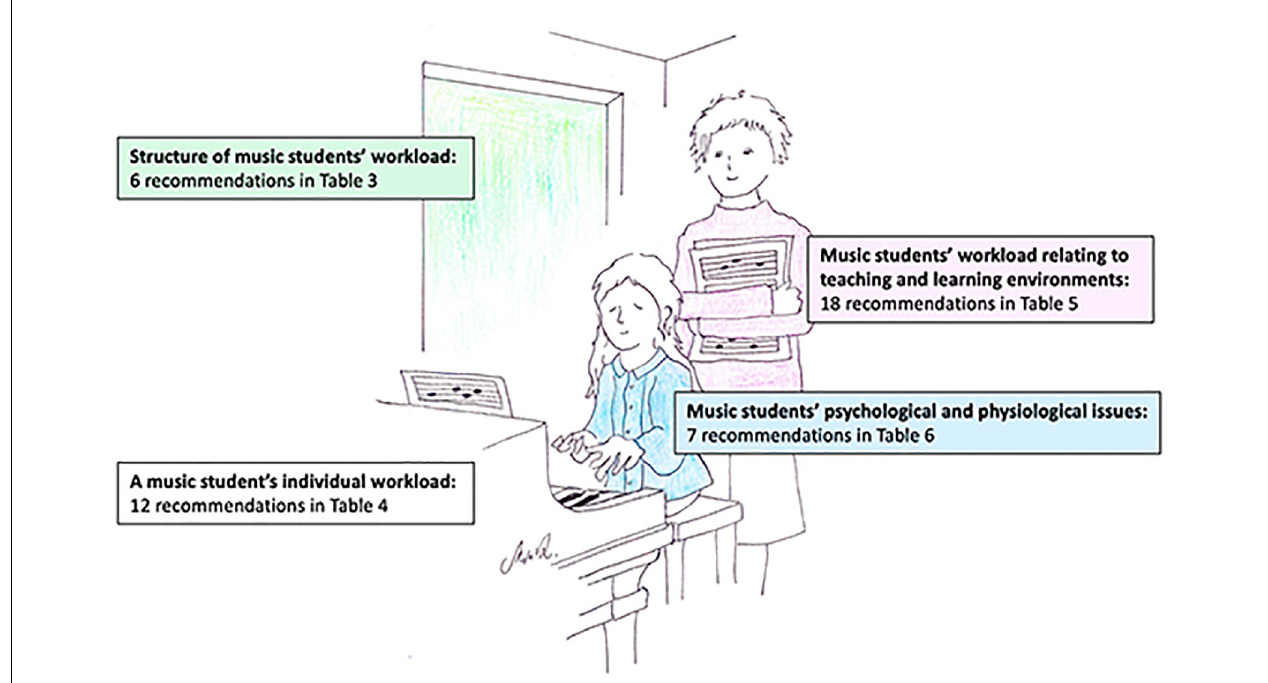
FIGURE 1 | Four categories including a total of 43 recommendations for tools for teachers to support music students in managing and coping with their workload in higher education.